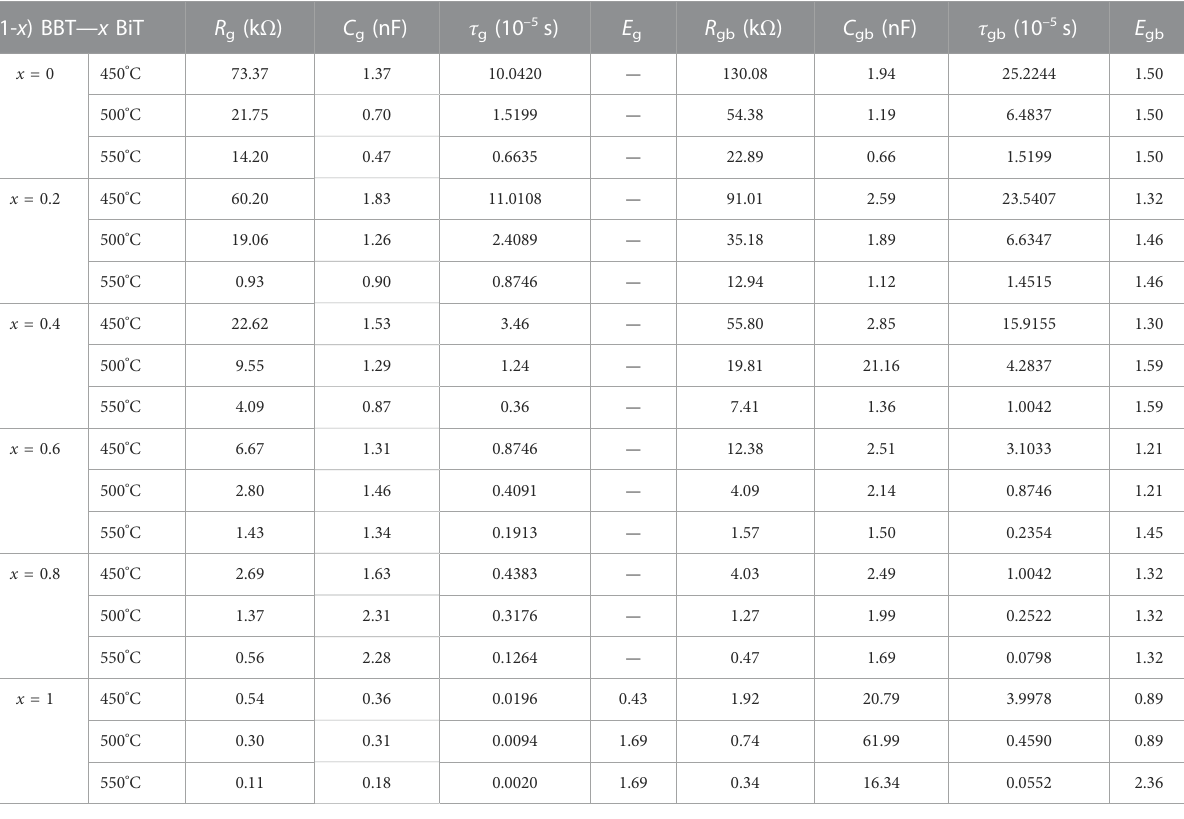
TABLE 2 Fitting results of all ceramics at the temperatures of 450 ° C, 500 ° C and 550 ° C: Resistance ( R g ), capacitance ( C g ), relaxation time determined ( τ g ) and relaxationactivationenergy( E g )forbulk(grain);resistance( R gb ),capacitance( C gb ),relaxationtimedetermined( τ gb )andrelaxationactivationenergy( E gb )for grain boundary.